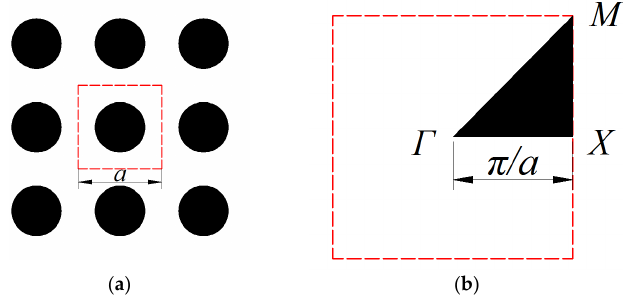
Figure 1. ( a ) Phononic crystals with 3 × 3 unit cells; and ( b ) irreducible first Brillouin zone ( Γ‐Χ‐Μ‐Γ ).